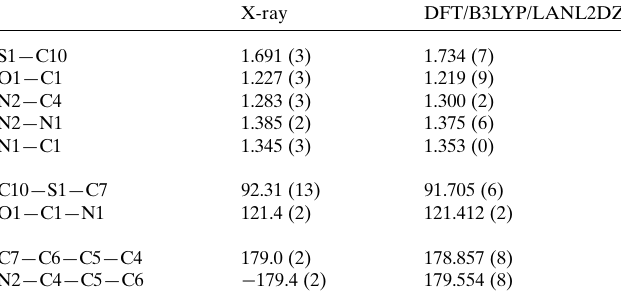
Table 1 Selected bond lengths, angles and torsion angles (A˚ , (cid:3) ).